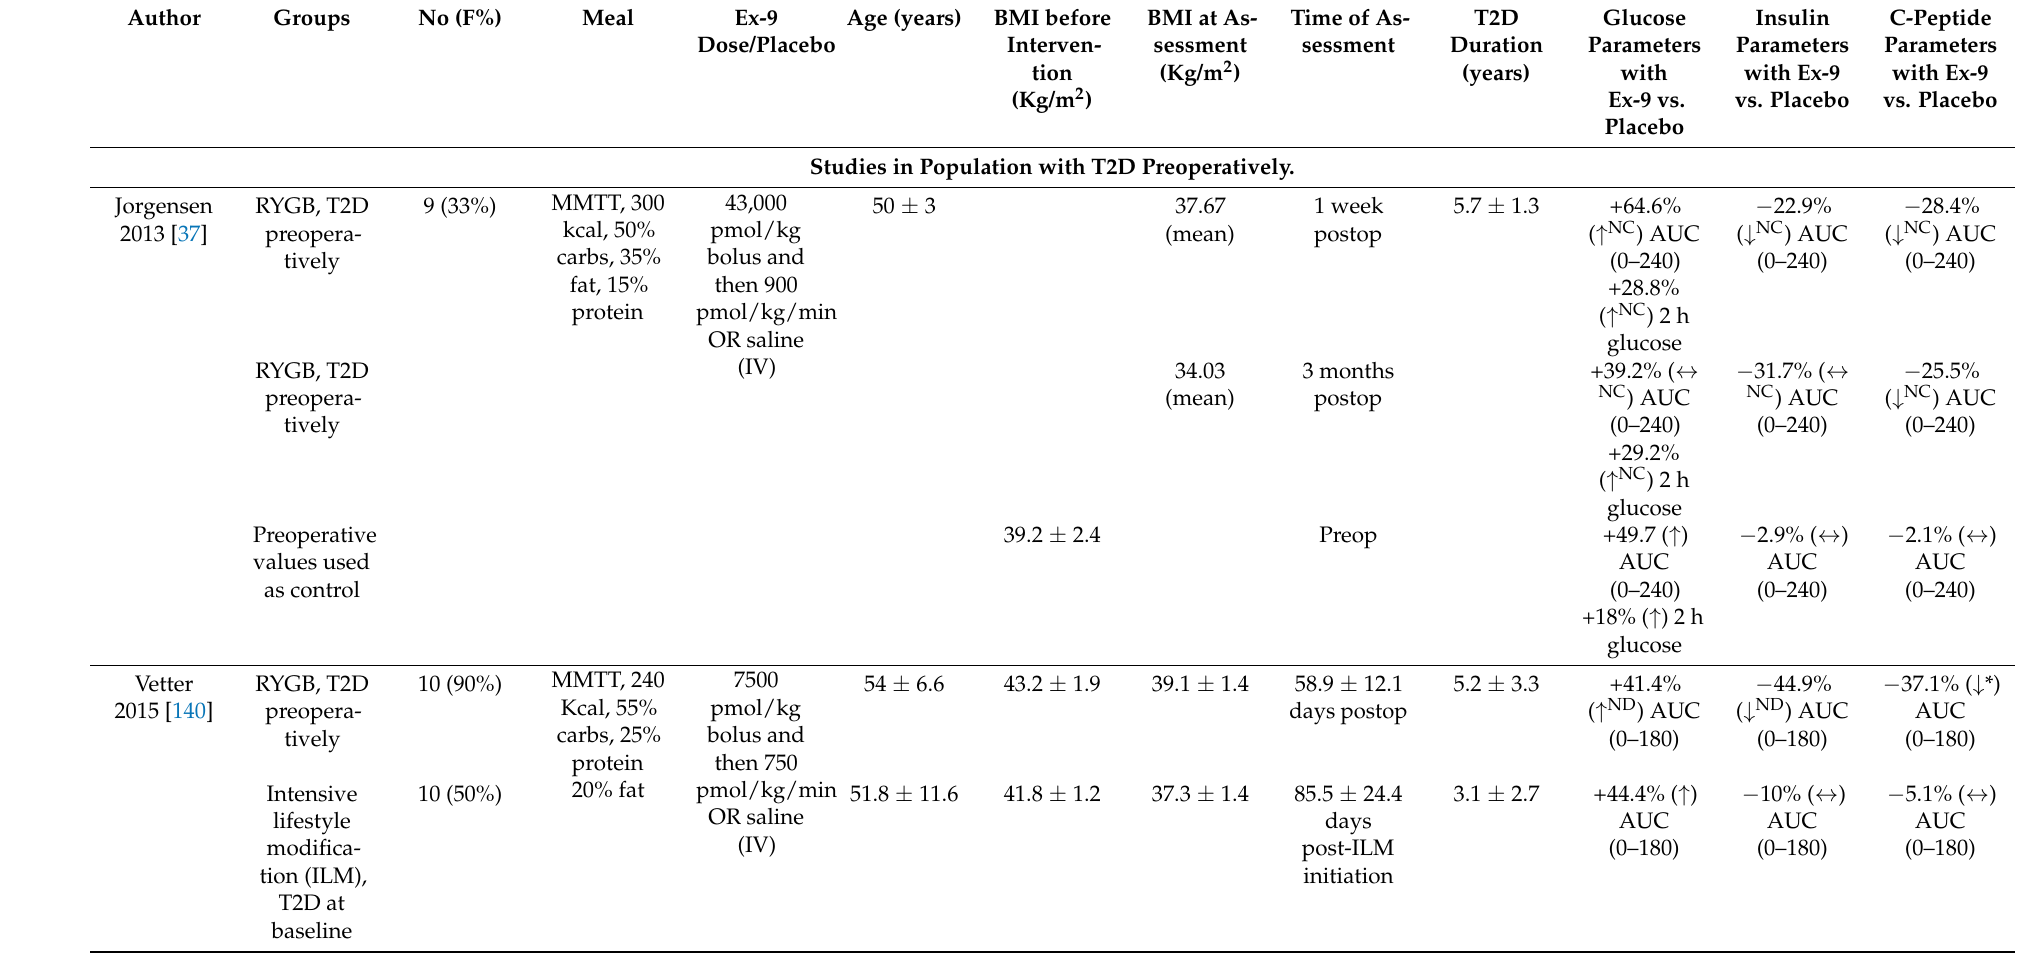
Table 3. Studies using the GLP-1 antagonist Exendin 9–39 to assess glycaemic outcomes in people with type 2 diabetes or postprandial hypoglycaemia after bariatric